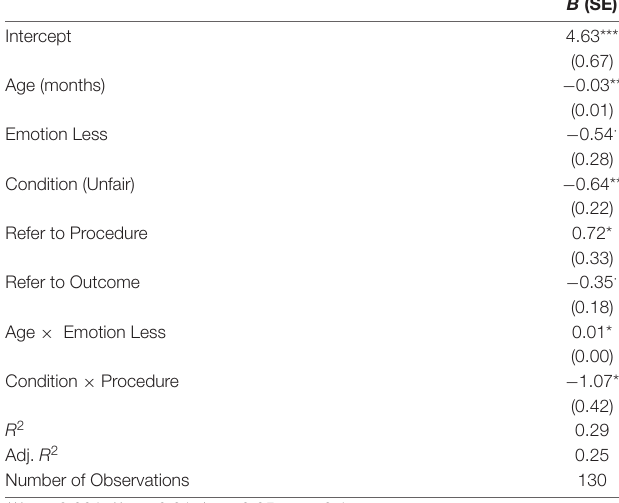
TABLE 1 | Combined model including justifications and emotion ratings.